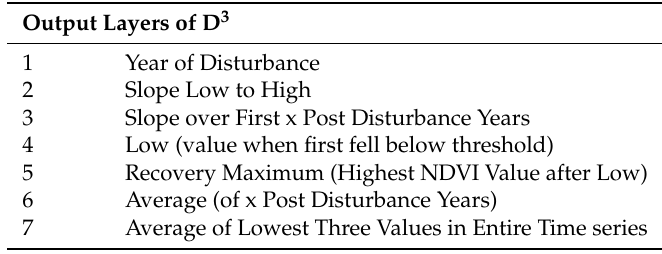
Table A2. D 3 Output’s 7 layers.